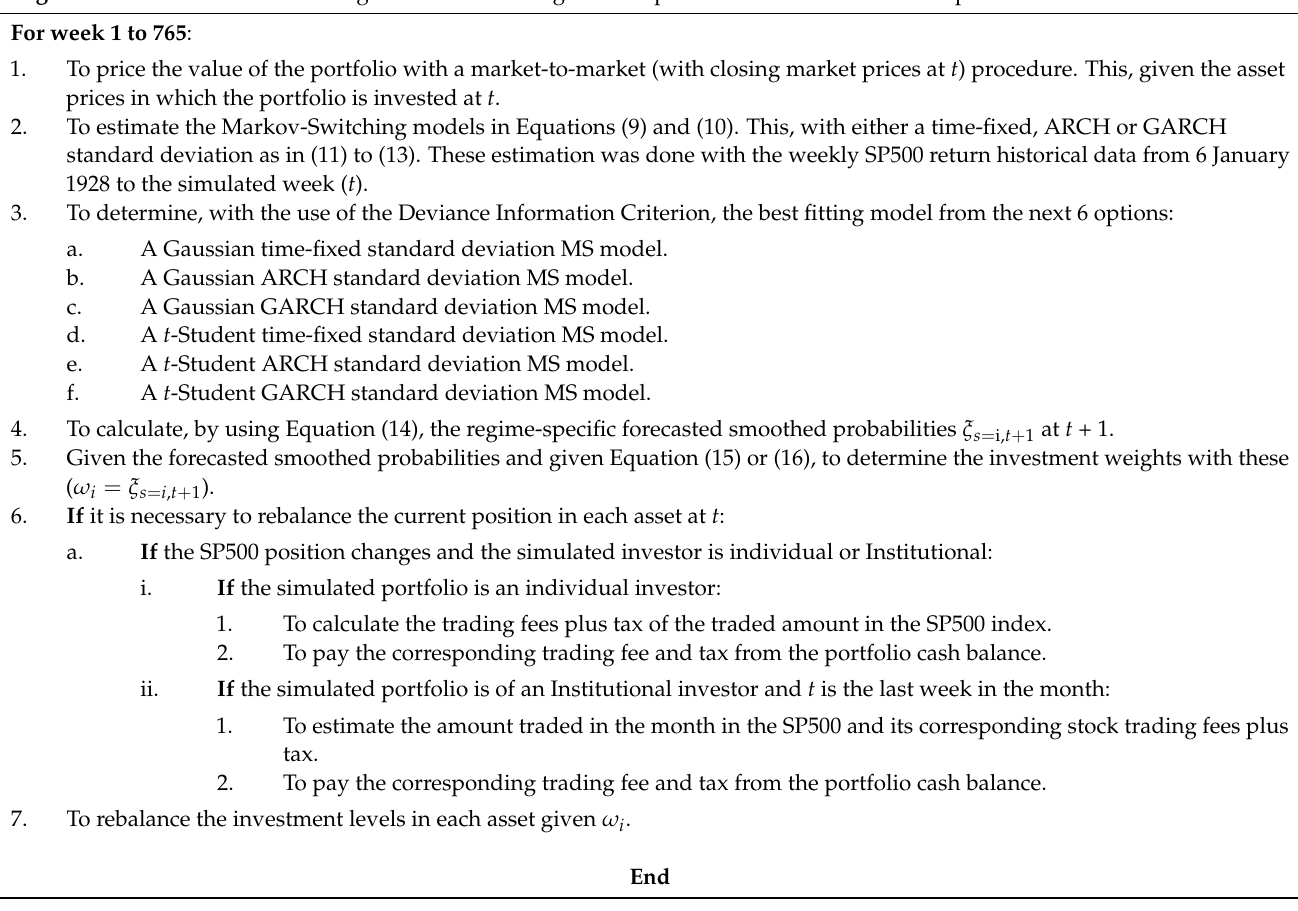
Algorithm 1 The Markov-Switching VIX investment algorithm’s pseudocode for the simulated